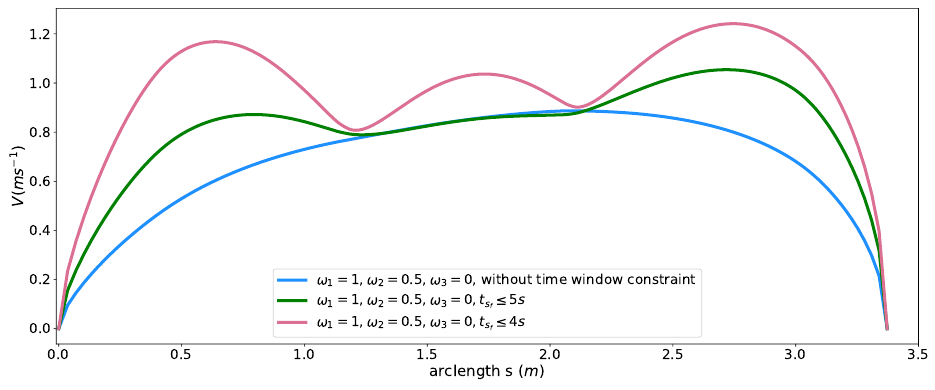
Figure 11. Speed planning results with time window